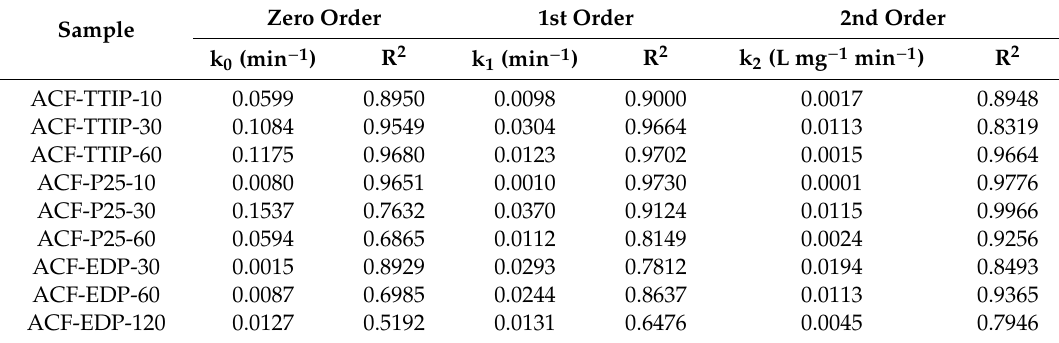
Figure 5. UV-Vis spectra of samples collected after 120 min of photocatalysis with the ( a ) ACF-TTIP-60, ( b ) ACF-P25-30, and ( c ) ACF-EDP-30 composite adsorbents. Table 4. Kinetic analysis of phenol photocatalytic degradation experiments.